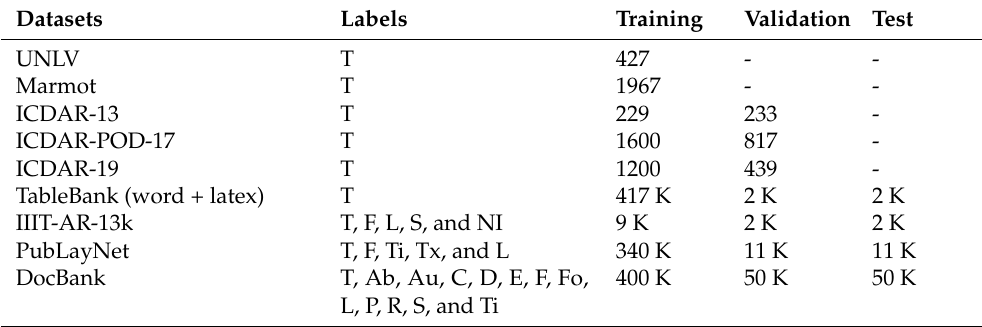
Table 2. Statistics of related datasets. T: indicates table, F: indicates figure, L: indicates list, S: indicates signature, NI: indicates natural images, Ti: indicates titles, Tx: indicates text, Ab: indicates abstract, Au: indicates author, C: indicates caption, D: indicates date, E: indicates equation, Fo: indicates footer, P: indicates paragraph, R: indicates reference, S: indicates